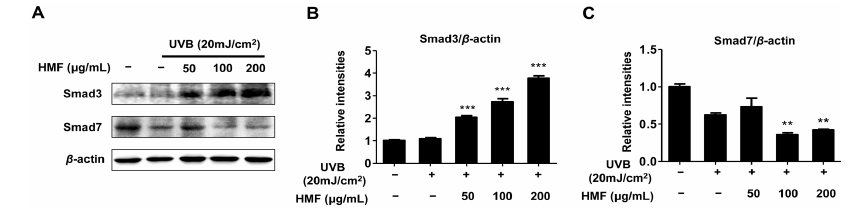
Figure 5. Effects of 3,5,6,7,8,3 (cid:48) ,4 (cid:48) -heptamethoxyflavone (HMF) on expression of Smad3 and Smad7 protein in HDFn cells. HDFn cells were treated with HFM (50, 100, and 200 µ g/mL) for 24 h following treatment with UVB irradiation (20 mJ/cm 2 ). Cellular protein levels were examined using ( A ) western blot analysis and ( B ) relative expression levels were calculated using the TL-100 software program (TotalLab, Newcastle, UK). Values are means ± standard deviation (SD) of three independent experiments. Statistical significance of differences was evaluated using one-way analysis of variance (ANOVA) followed by Tukey’s test. ** p < 0.01 and *** p < 0.001 versus HDFn cells without HMF